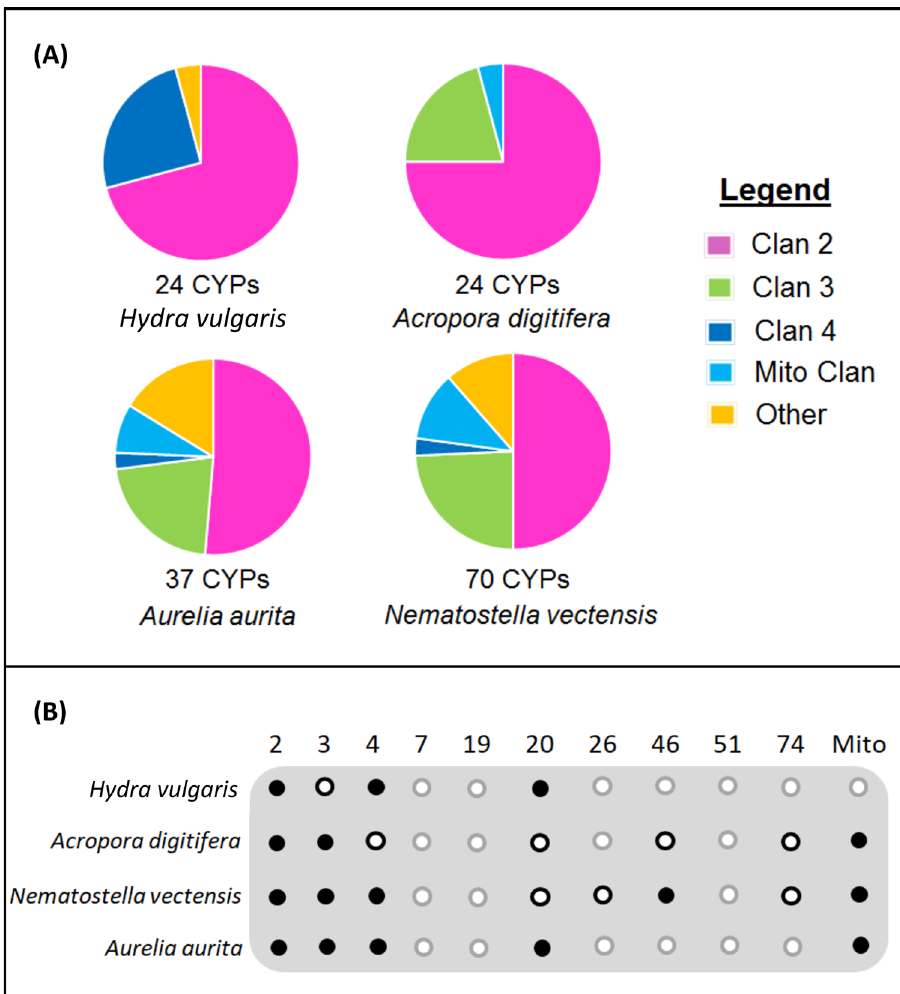
Figure 3. The distribution of cytochrome P450 genes among the metazoan CYP clans in four cnidarian species. ( A ) The proportion of each species’ CYPome that falls within the major metazoan clans (clan 2, clan 3, clan 4 and the mitochondrial clan). The number of CYP genes included in the analysis is indicated under each chart and includes all of the complete and partial CYPs from each species. Clan 16, clan 20 and clan 46 CYPs, as well as five A. aurita CYPs that did not fall discretely within any of the established metazoan CYP clans were designated as ‘Other’. ( B ) The presence or absence of each of the twelve metazoan CYP clans within each cnidarian species. Each column represents a different clan, and each row represents a different species. A filled black dot means that the clan was identified in the complete or partial genes, a white dot with a black outline means that the clan was identified in the fragmentary genes, and a white dot with a grey outline means that the clan was not found in the data. We have included CYP16 in Clan 16 because this clan designation has recently been determined by the nomenclature committee and other phylogenetic analyses support that CYP16 forms a separate clan 61 . In our phylogenetic analyses, the CYP16 genes clustered with Clan 26 genes (Fig.